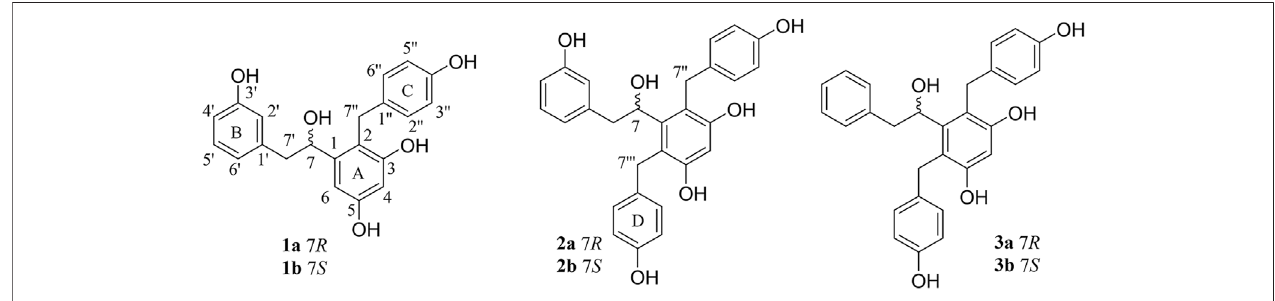
FIGURE 1 | Isolated compounds 1 – 3 from the tubers of B .